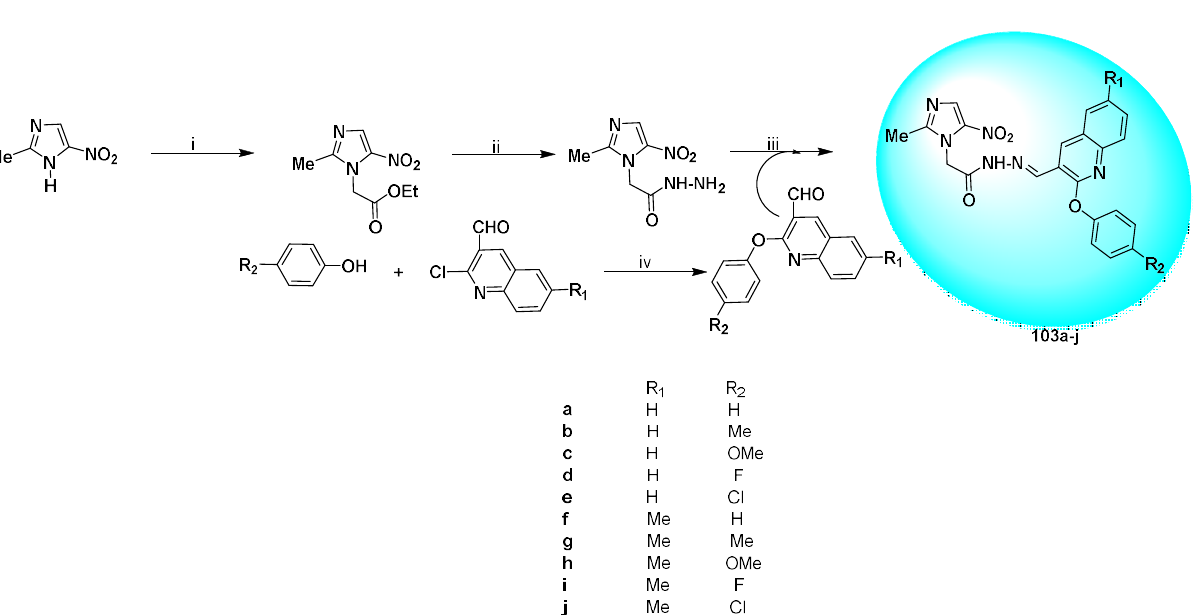
Scheme 48. 5-Nitroimidazole derivatives as anticancer agents.Reagents and conditions: ( i